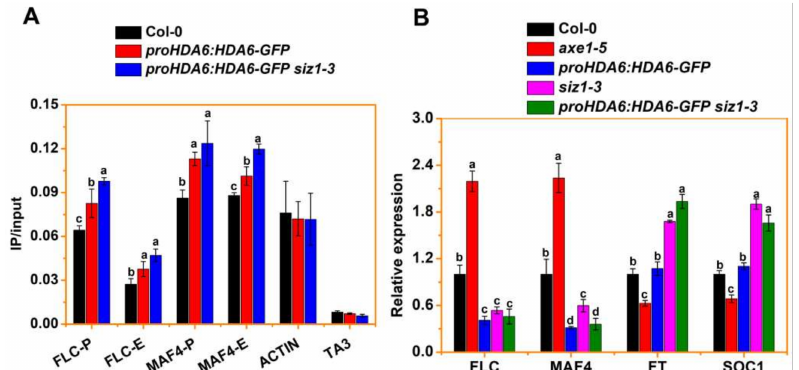
Figure 4. SIZ1 inhibits HDA6 binding to FLC and MAF4 loci. ( A ) ChIP-qPCR analysis of proHDA6:HDA6-GFP siz1-3 DNA fragments co-immunoprecipitated with the anti-GFP antibody in FLC and MAF4 chromatin. Relative enrichment was calculated based on IP/input for each sample. TA3 and ACTIN2 were used as the negative control. Values are shown as means ± SE. Error bars correspond to standard deviations from three biological replicates. Different letters are used to indicate means that are significantly different between mutant and WT treatments ( p < 0.05, post hoc test). ( B ) qRT-PCR analysis of the expression levels of FLC , MAF4 , FT , and SOC1 in 15-day-old WT, axe1-5 , proHDA6:HDA6-GFP , siz1-3 , and proHDA6:HDA6-GFP siz1-3 plants under LD conditions. ACTIN2 was used as an internal control. Values are shown as means ± SE. Error bars correspond to standard deviations from three biological replicates. Different letters are used to indicate means that are significantly different between mutant and WT ( p < 0.05, post hoc